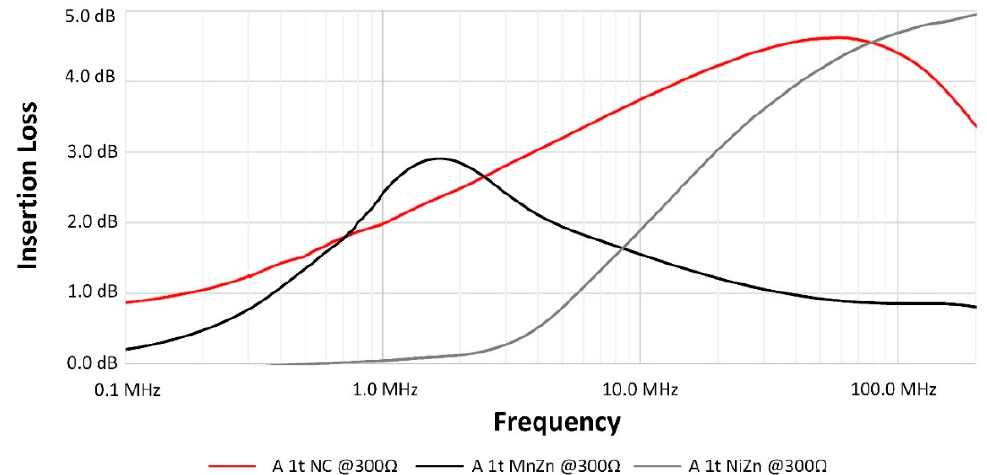
Figure 13. Comparison of the experimental insertion loss determined for NC, MnZn and NiZn sleeve ferrite cores by winding one turn.